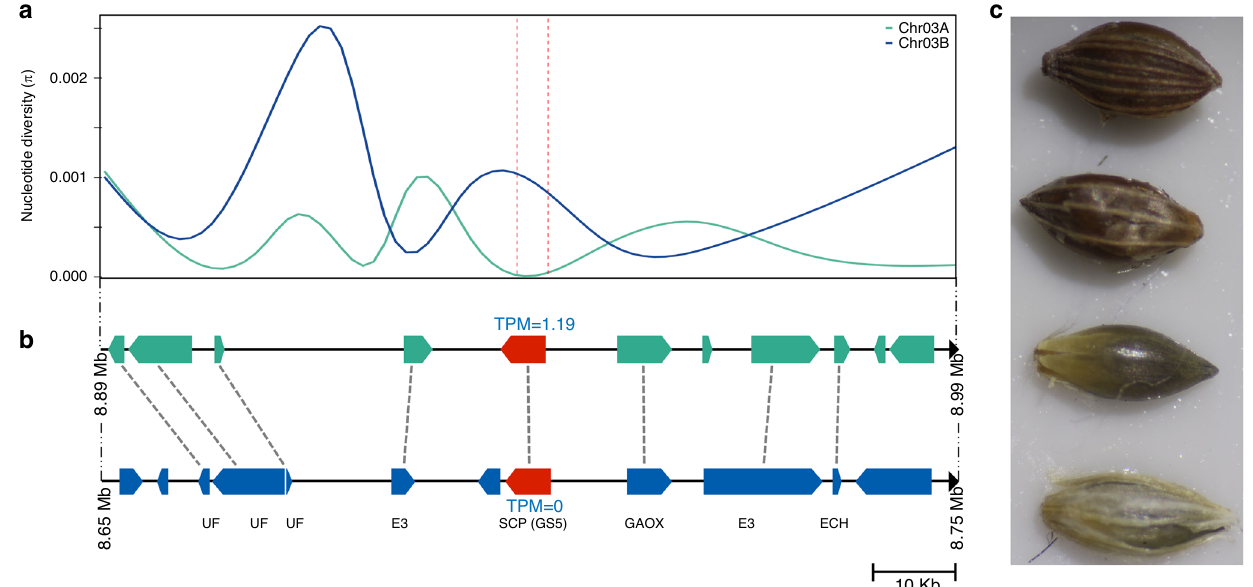
Fig. 5 Selective sweep at the GS5 locus in fonio. a Smoothed representation of nucleotide diversity ( π ) in D. exilis in a 100kb window surrounding the ortholog of the rice GS5 gene. The green curve shows π around DeGS5-3A on chromosome 3A and the blue curve shows π around DeGS5-3B on chromosome 3B. The dashed vertical red lines represent the location of the GS5 genes. The nucleotide diversity was calculated in overlapping 100 bp windows every 25bp. b Schematic representation of the annotated genes in the GS5 regions and the orthologous gene relationships between chromosomes 3A (green) and 3B (blue). UF protein of unknown function, E3 E3 ubiquitin ligase, SCP ( GS5 ) serine carboxypeptidase (Dexi3A01G0012320), GAOX gibberellin 2-beta- dioxygenase, ECH golgi apparatus membrane protein. DeGS5-3A and DeGS5-3B are indicated in red. The numbers in blue above and below the GS5 orthologs show their respective expression in transcripts per million (TPM) in grain tissue. c Two grains of D. exilis (top) and D. longi fl ora